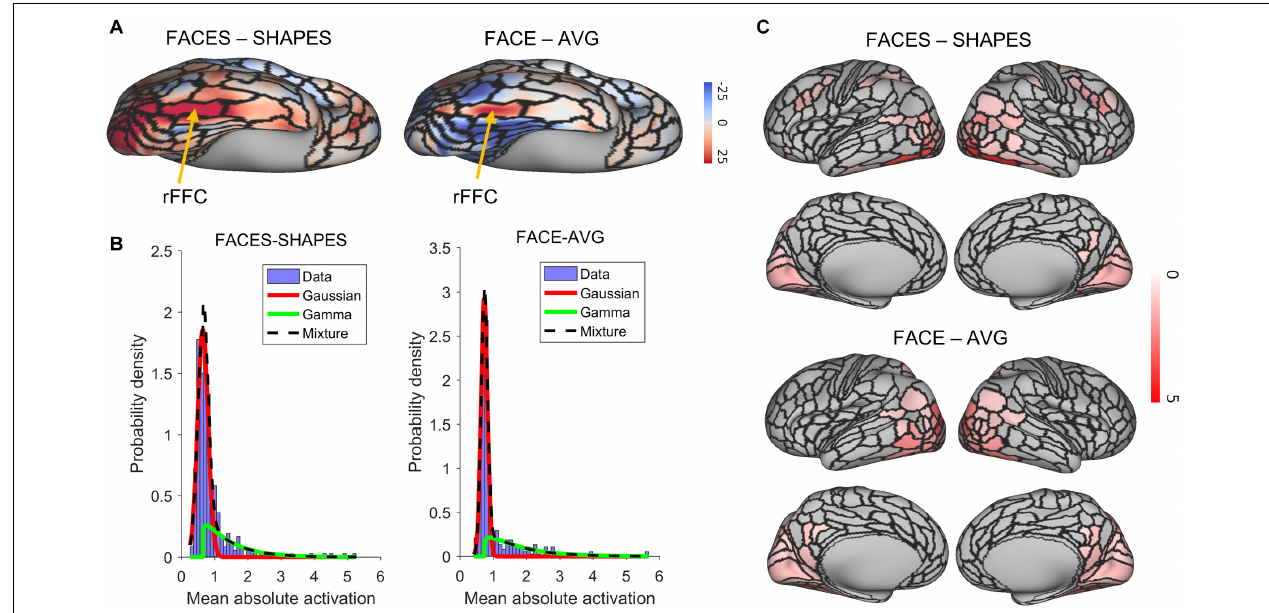
FIGURE 2 | Functional face ROI localization and network selection. (A) Voxel-wise group average z -statistics of both contrasts were shown. The yellow arrow indicates the area where the rFFC region locates. (B) The purple histogram indicates the density distribution of the mean absolute activation for the 360 brain regions. A Gaussian (red curve)-Gamma (green curve) mixture (black curve) model was used to fit the data. (C) Mean absolute z -statistics of brain regions in the functional face activation network were shown.